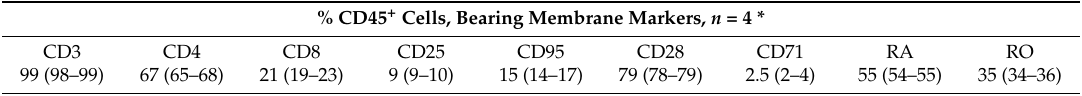
Table 1. Molecular determinants of HBMLs after 24 h of in vitro culture, Me (Q1–Q3).